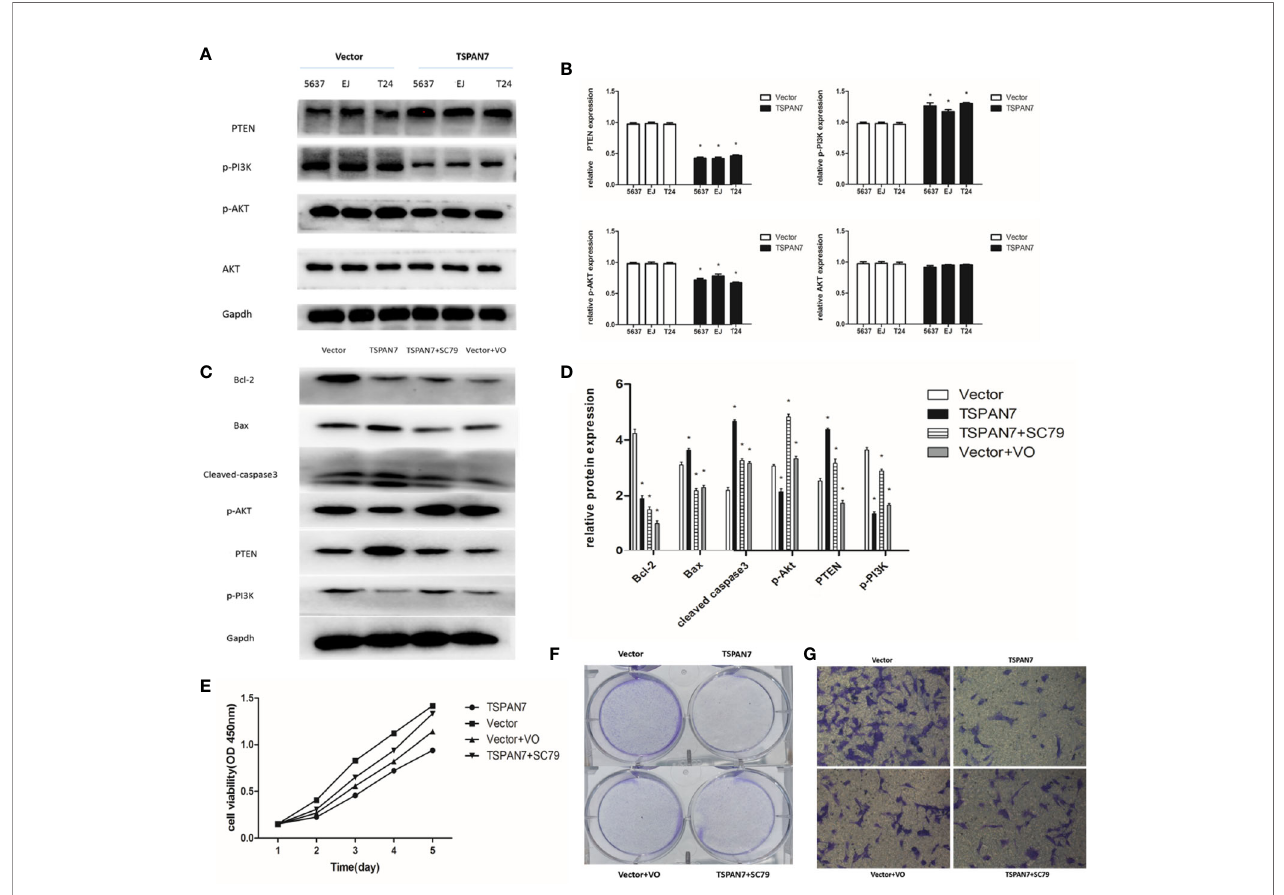
FIGURE 7 | TSPAN7 inhibits proliferation in BCa cell lines via PTEN-PI3K/AKT pathways. (A, B) TSPAN7 overexpression in BCa cells downregulated the expression of p-PI3K and p-AKT, and upregulated the expression of PTEN. (C, D) In Western blot, AKT agonist SC79 could reverse the effect of TSPAN7 overexpression on T24 cells and PTEN inhibitor VO-Ohpic trihydrate caused the similar effect on pcDNA-vector T24 cells. (E – G) In the presence of SC79, the proliferation, migration and invasion of pcDNA-TSPAN7 T24 cells were clearly elevated and inhibition of PTEN in T24 cells distinctly decreased cell growth, migration and invasion. *P < 0.05 vs. the corresponding NC cells. All the above data are the mean ± SD from an average of three